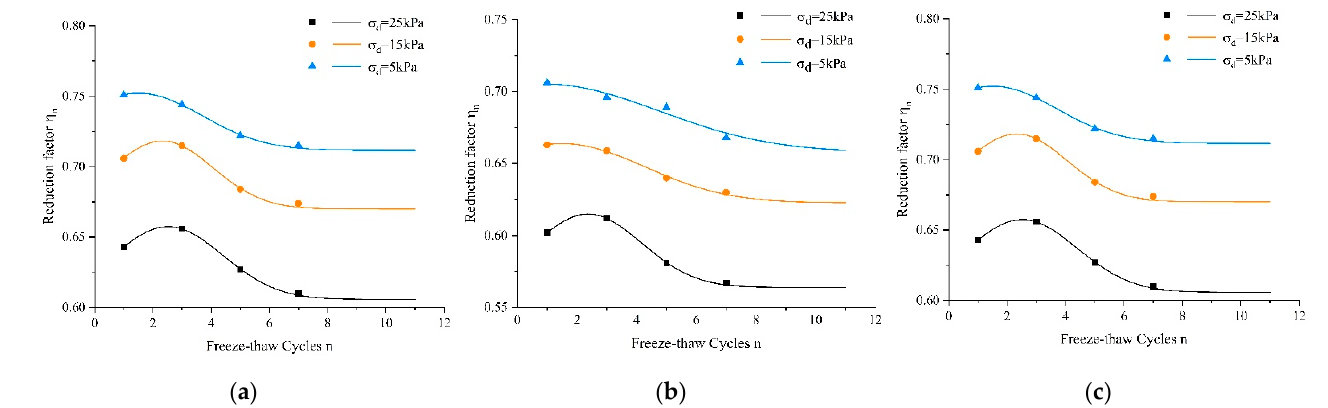
Figure 4. Fitting curves of freeze–thaw reduction coefficients. ( a ) σ 3 = 50 kPa; ( b ) σ 3 = 40 kPa; ( c ) σ 3 = 30 kPa. Table 5. Fitting parameters of freeze–thaw reduction